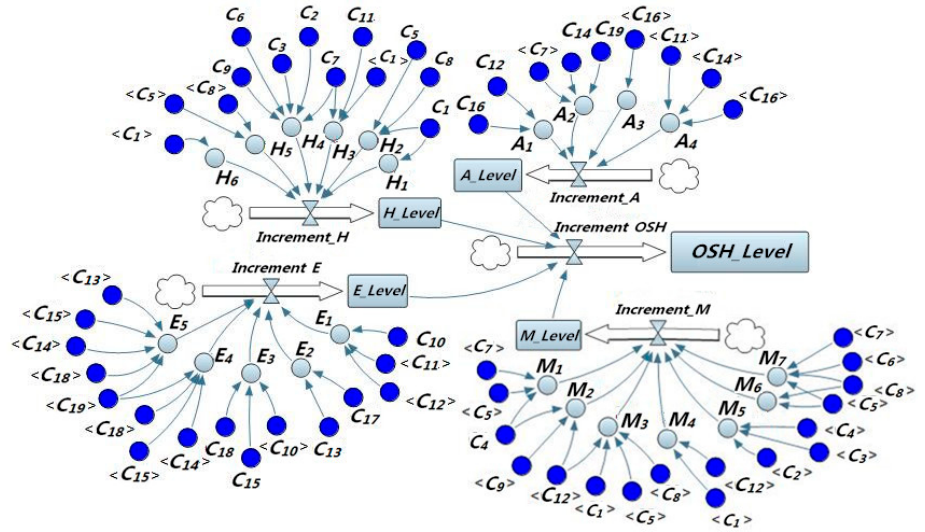
Figure 4. Management and Control Measures System Dynamics (SD) Model.